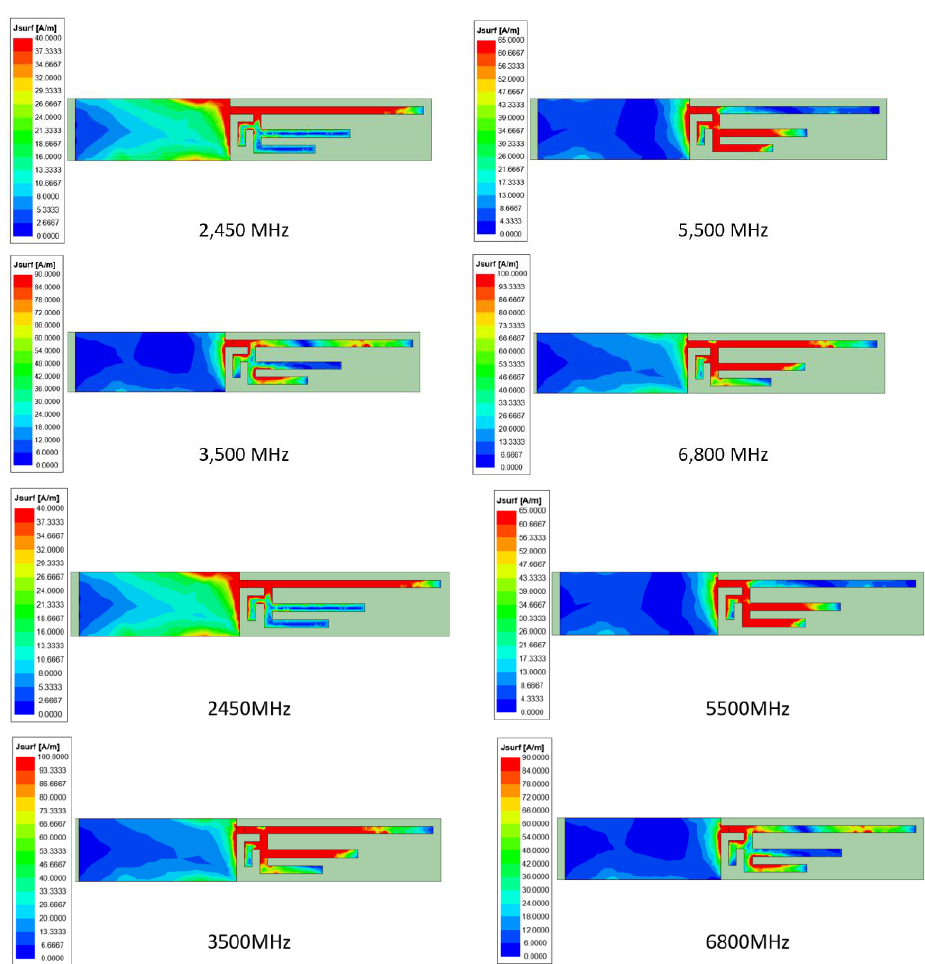
Figure 9. Surface-current simulation results when the working resonance point of Ant. 1 is located at 2450 MHz, 3500 MHz, 5500 MHz, and 6800 MHz.